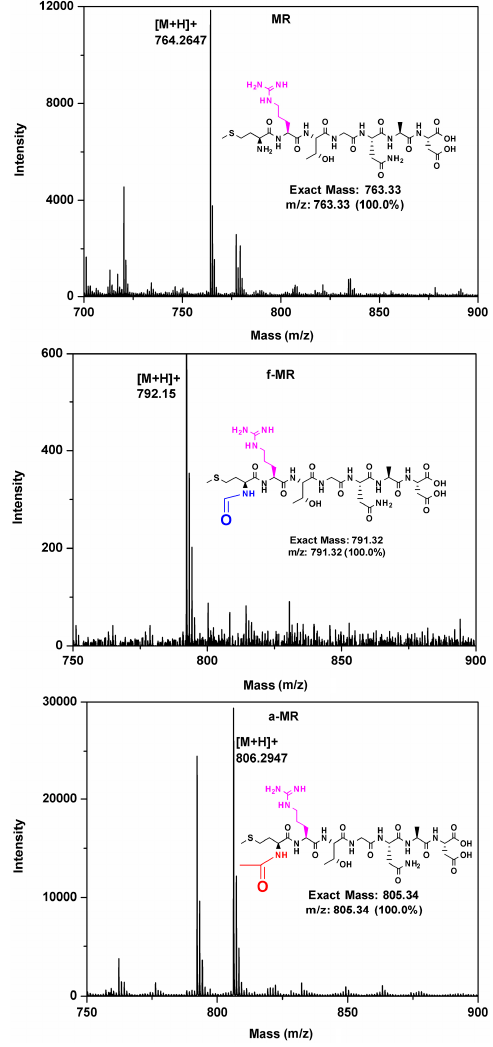
Figure 2. The MALDI-TOF MS analyses of peptides are shown.